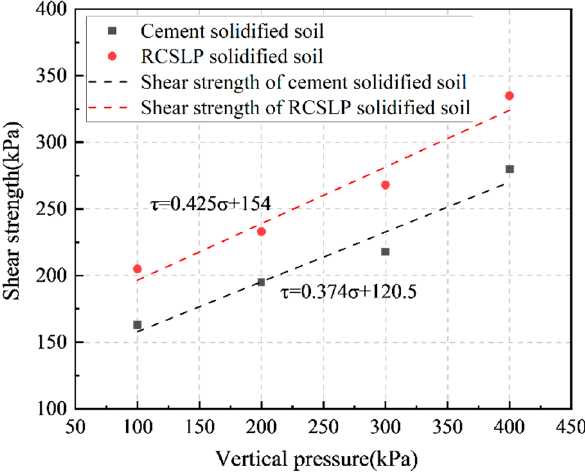
Figure 12. Shear strength of the solidified soil after 28